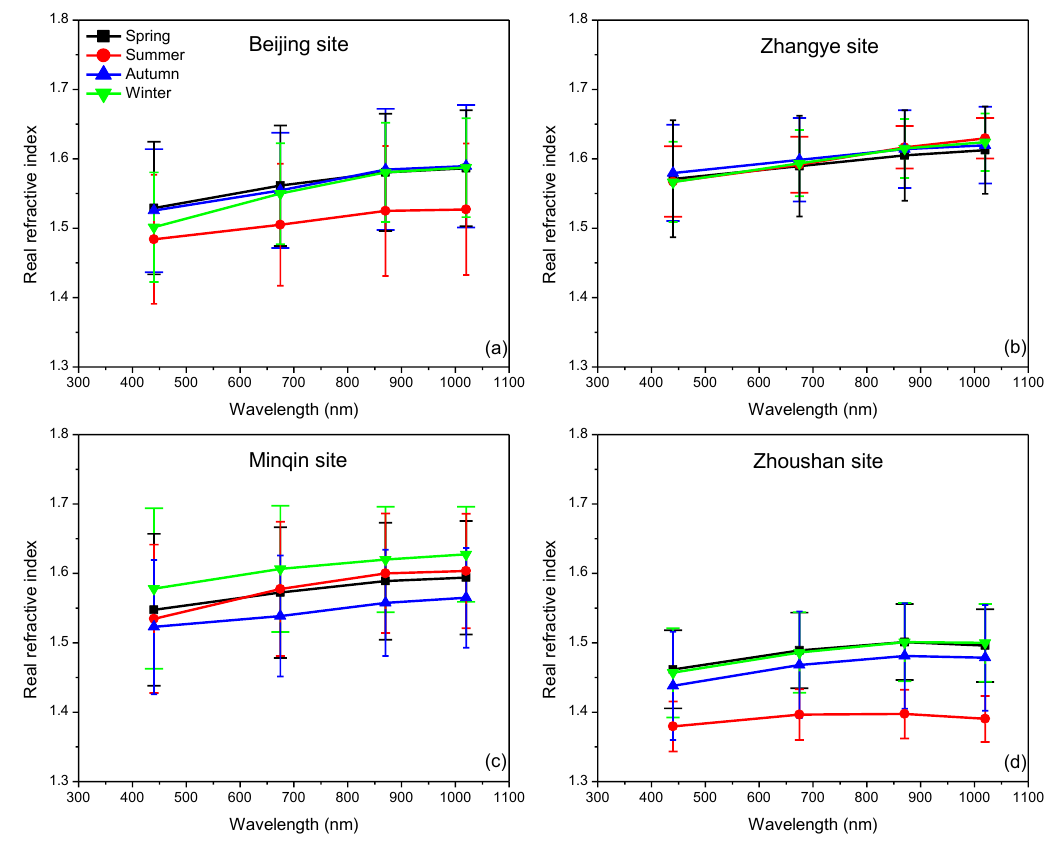
Figure 5. Seasonal average of real refractive indices of the four sites, ( a ) Beijing site; ( b ) Zhangye site; ( c ) Minqin site; ( d ) Zhoushan site. Error bar indicates the standard deviation of the